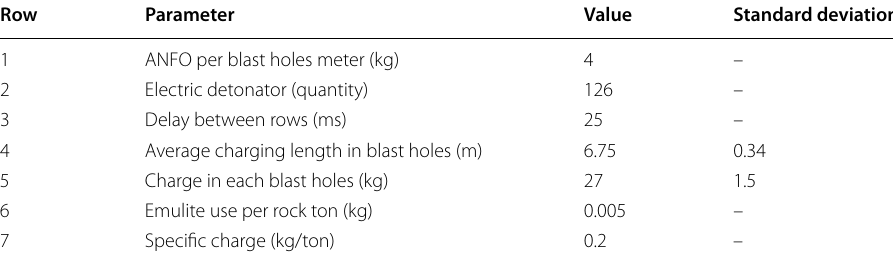
Table 2 Blasting and explosives data